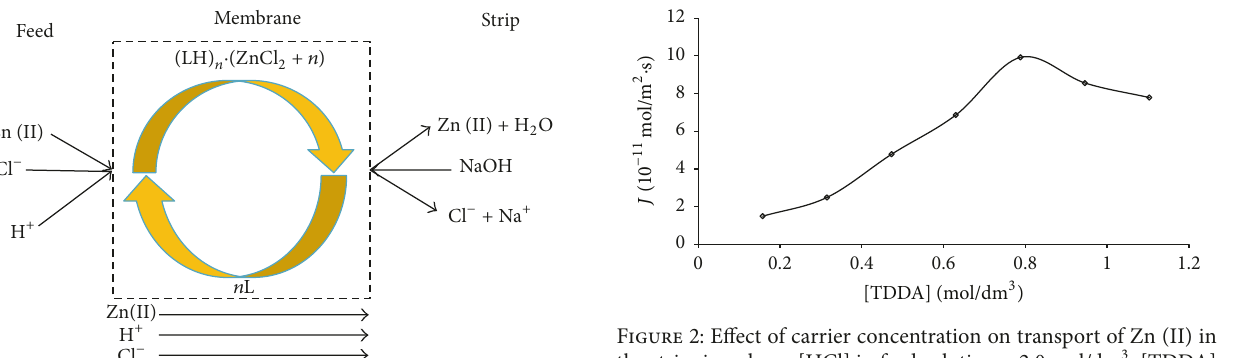
0.9996y = 2.0083x − R 2 =